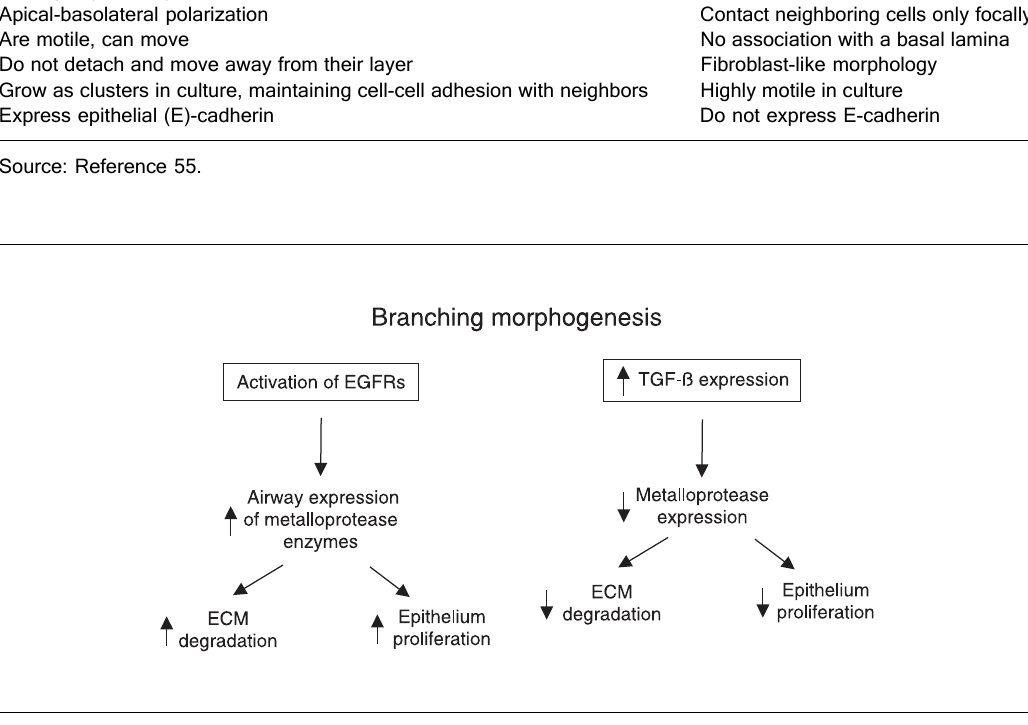
Figure 3. Communication between epithelium and the underlying epithelial fibroblast sheet is reminiscent of the process that drives branching morphogenesis, whereas epithelium and mesenchyme act as a trophic unit. Intermit- tent EGF and TGF-ß dominance produces alternating linear and branching of the developing airways, in a process similar to that observed in asthmatic airways (53). EGFRs = epidermal growth factor receptors; TGF-ß = transforming growth factor-ß; ECM = extracellular